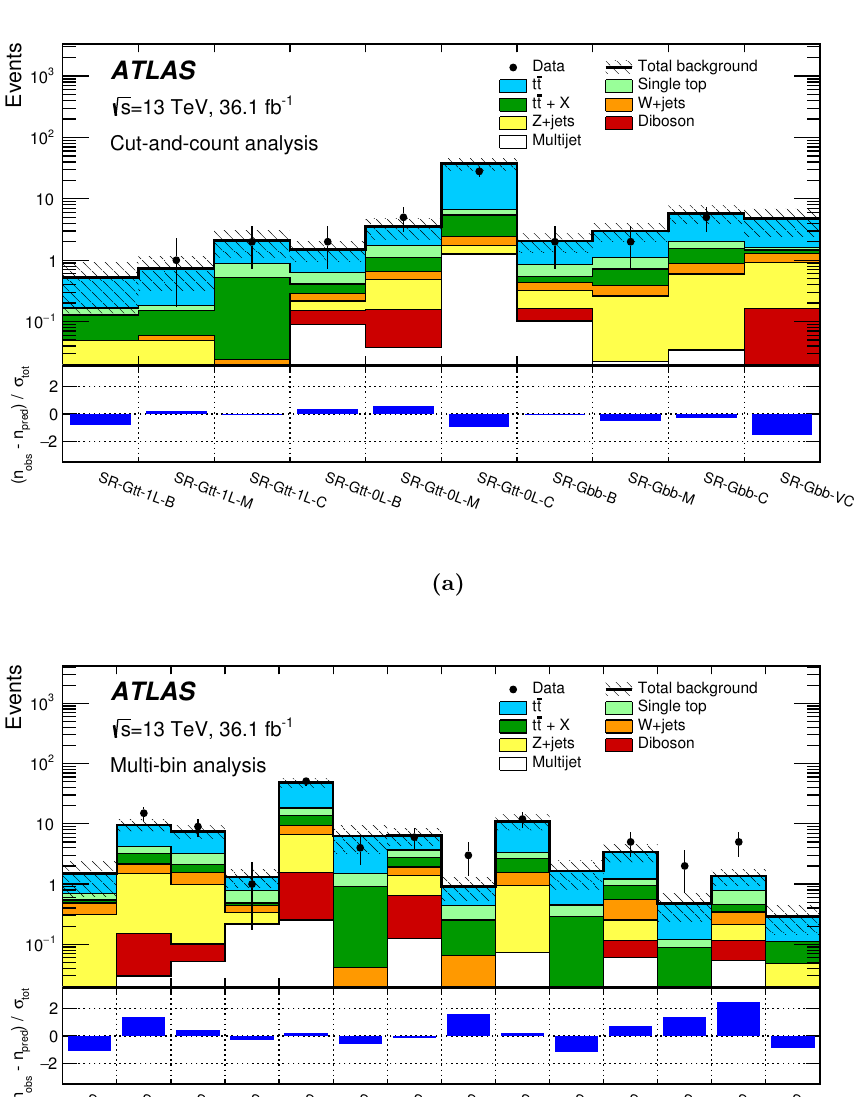
Figure 9. Results of the background-only (cid:12)t extrapolated to the SRs for (a) the cut-and-count and (b) the multi-bin analyses. The data in the SRs are not included in the (cid:12)t. The upper panel shows the observed number of events and the predicted background yield. All uncertainties de(cid:12)ned in section 7 are included in the uncertainty band. The background category t (cid:22) t + X includes t (cid:22) tW=Z , t (cid:22) tH and t (cid:22) tt (cid:22) t events. The lower panel shows the pulls in each SR.